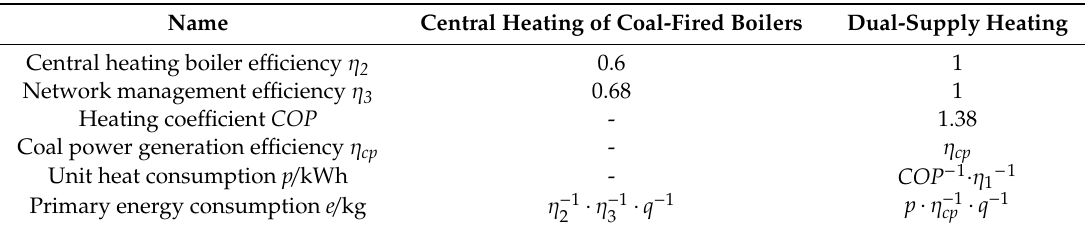
Table 1. Winter heating energy consumption and cost parameters [20].